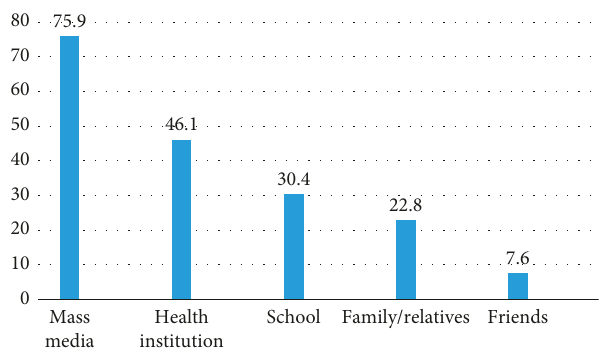
Figure 1: Women’s source of information for preconception folic acid supplementation in Adet, Gojjam, Northwestern Ethiopia, 2016 ( n � 79). Note that the total summation of percentage is more than 100% due to multiple answers.